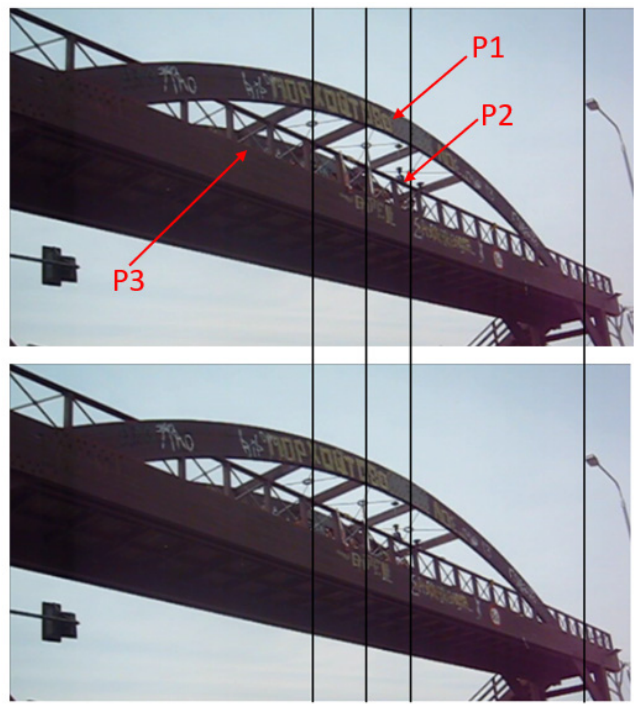
Figure 2. Two snapshots of a part of the Kanellopoulos bridge during a forced controlled excitation. Vertical lines are added to highlight the high amplitude of the bridge deflections. In the lower figure, the polygonal connections of steel X-braces at the roof of the bridge are seen to be displaced during a force-excitation event by jumping pedestrians (hardly shown on the bridge). The width of the polygonal connection, about 15 cm, indicates the order of magnitude of the lateral deflections of the bridge. These deflections are at a maximum at point P1, slightly smaller at point P2 at the midspan, and even smaller at point P3, the approximate position of which is shown using arrows. These photos are from a video shot from a location near to those of the analyzed videos.